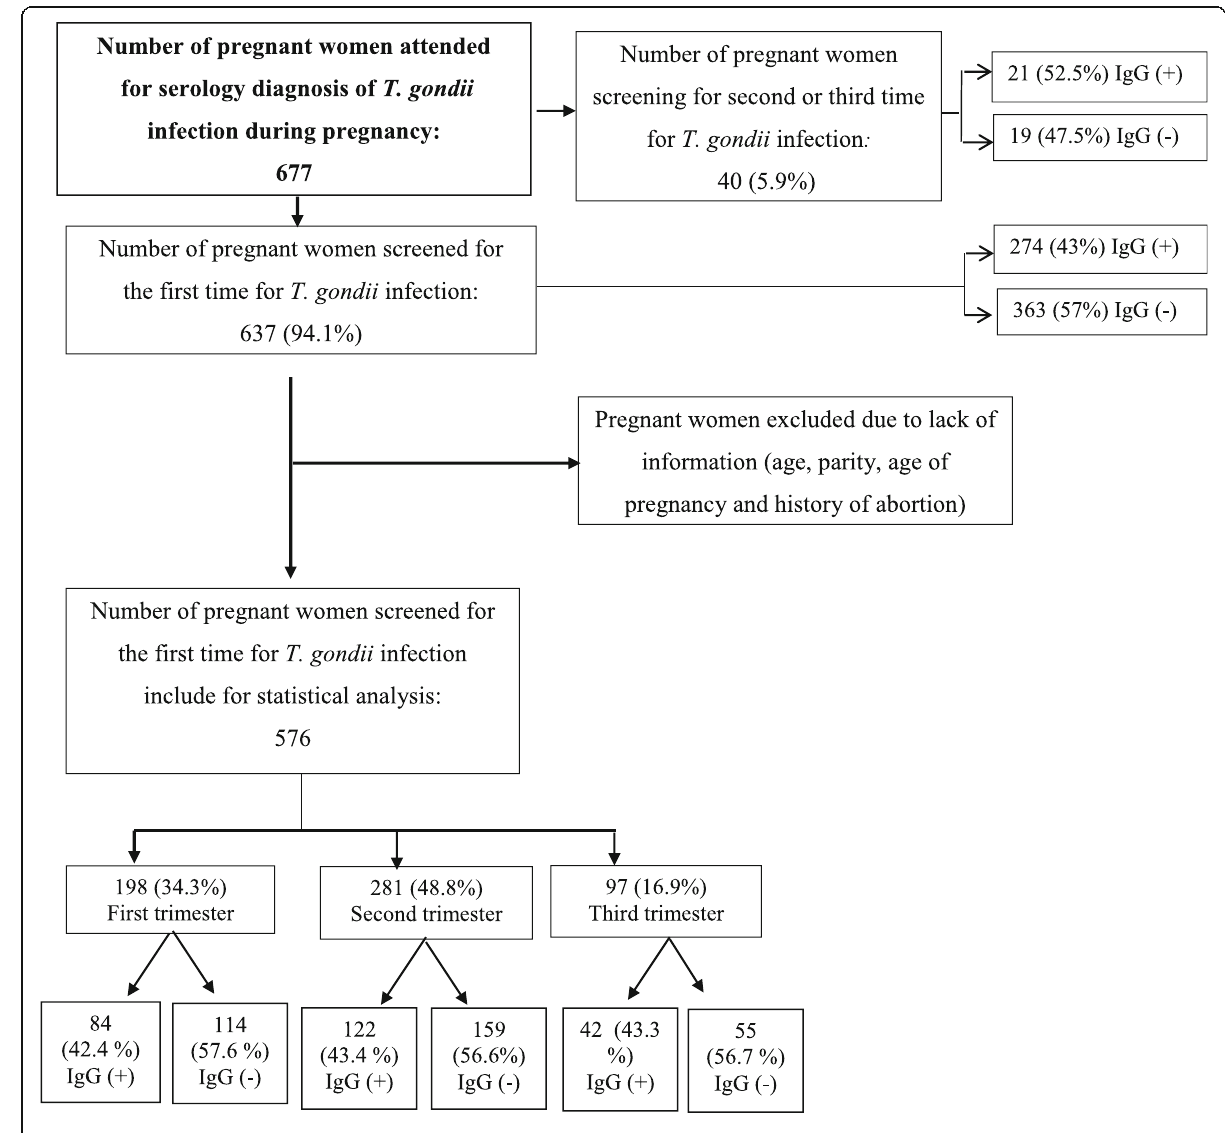
Fig. 1 Flowchart explaining the selection of data for the analysis with details of their distribution of pregnant women by serological status for Immunoglobulin G Toxoplasma gondii infection